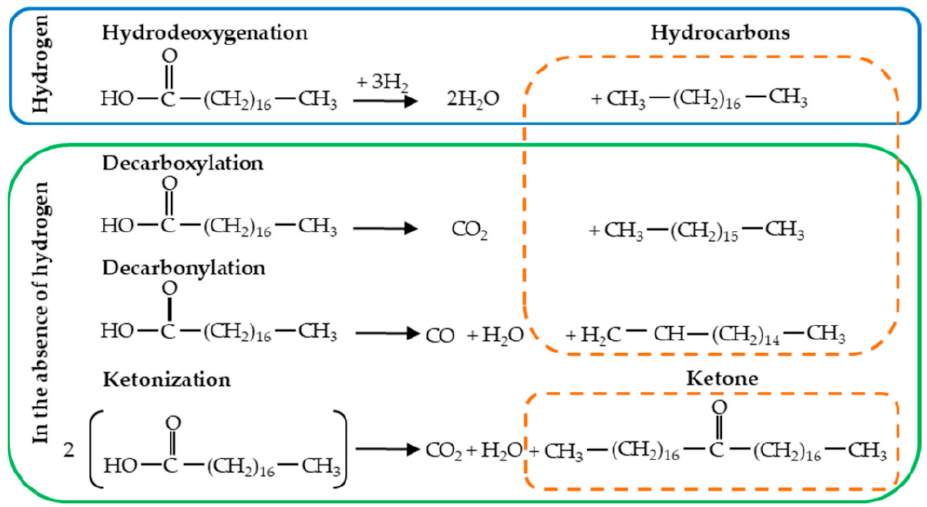
Figure 2. Representation of plausible reaction routes for the deoxygenation of stearic acid using hydro- gen (hydrogenation) or in the absence of this gas (decarboxylation, decarbonylation, and